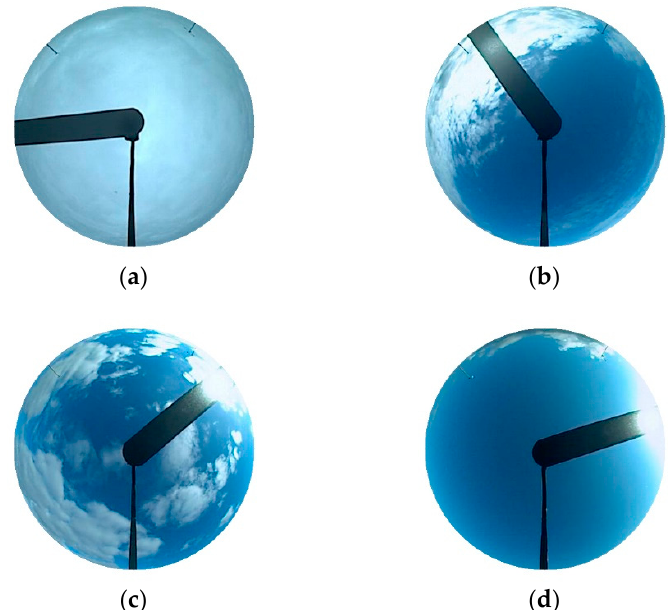
Figure 8. Four categories of images: ( a ) Overcast sky; ( b ) cloudy sky without sun; ( c ) cloudy sky with sun; ( d ) clear sky.